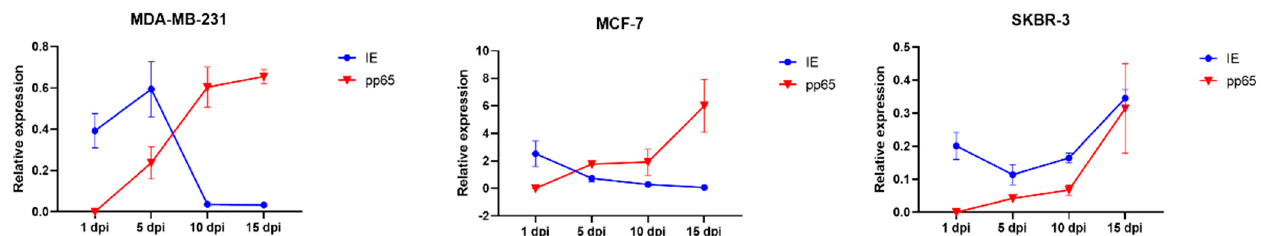
Figure 4. Detection of HCMV transcripts in three different breast cancer cell lines over time of infection. While expression of HCMV-IE transcripts disappeared over time in MDA-MB-231 and MCF-7 cell lines, expression of HCMV-pp65 transcripts persisted and were enhanced over time of infection. Expression of HCMV-IE and HCMV-pp65 transcripts were also detectable in the SK-BR-3 cell line over time of infection and increased at 15 dpi. Transcript levels of HCMV-IE and HCMV-pp65 were normalized to housekeeping gene B2M at different time points (1, 5, 10, and 15 dpi) in three different breast cancer cell lines (MDA-MB 231 on the left, MCF-7 center, and SK-BR-3 on the right). Assays were performed in three separate experiments.